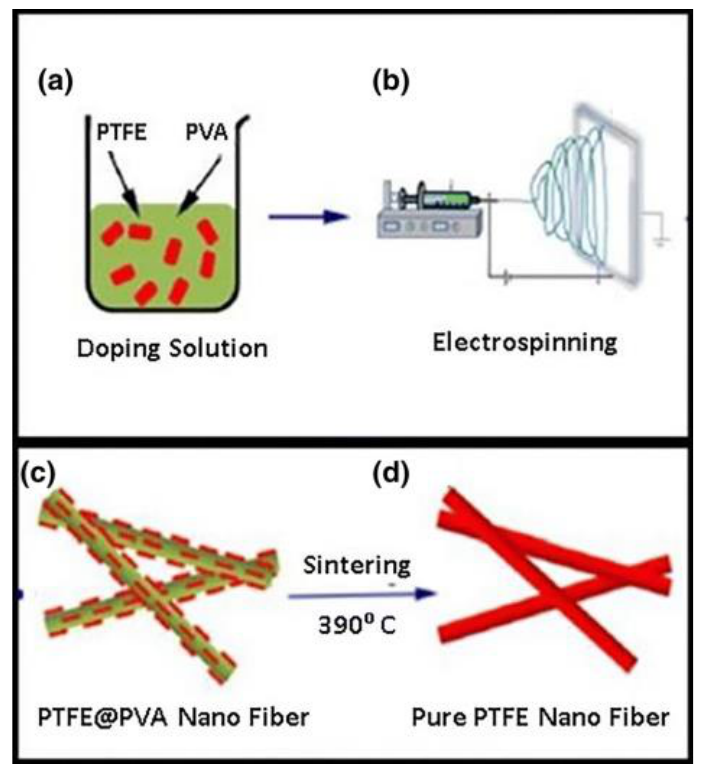
Figure 9. Manufacturing procedure of the PTFE nanofibrous membrane. Used from [92].